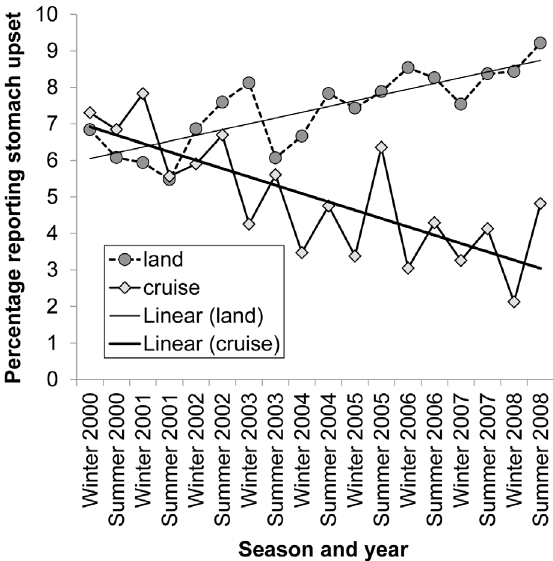
Figure 2. Trends in reports of stomach upset over time. Where S=Summer and W=Winter. Regression line for cruise-related stomach upset per year: R 2 =0.8984; regression line for land-based holiday- related stomach upset: R 2 =0.